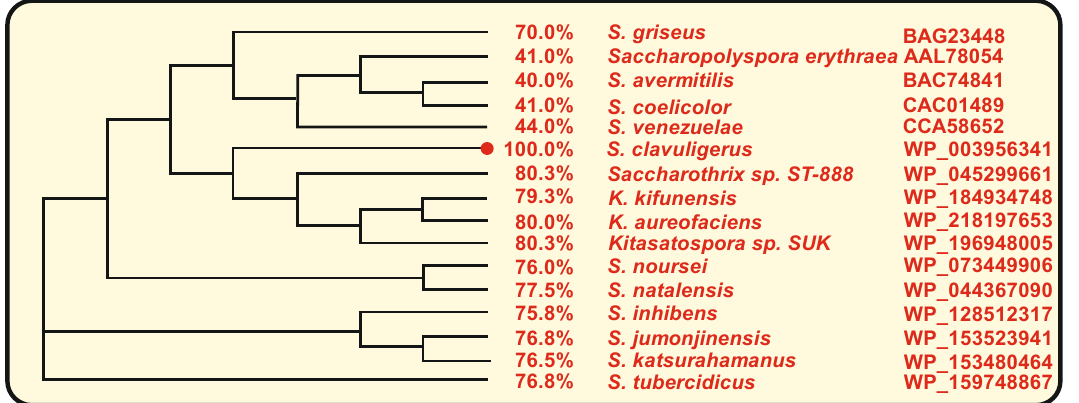
Figure 5. Phylogenetic tree of cytochrome P 450 monooxygenases. The identity percentage of each P 450 with respect to S. clavuligerus NcyP, the name of the actinobacteria and its accession number is indicated next to each branch. The phylogenetic tree was obtained using the Clustal Omega